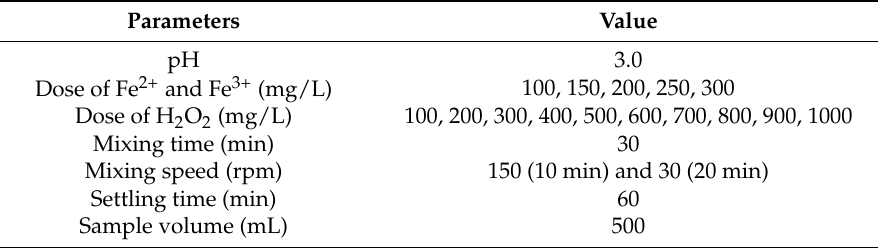
Table 1. The experimental conditions for the Fenton (Fe 2+ , Fe 3+ ) oxidation